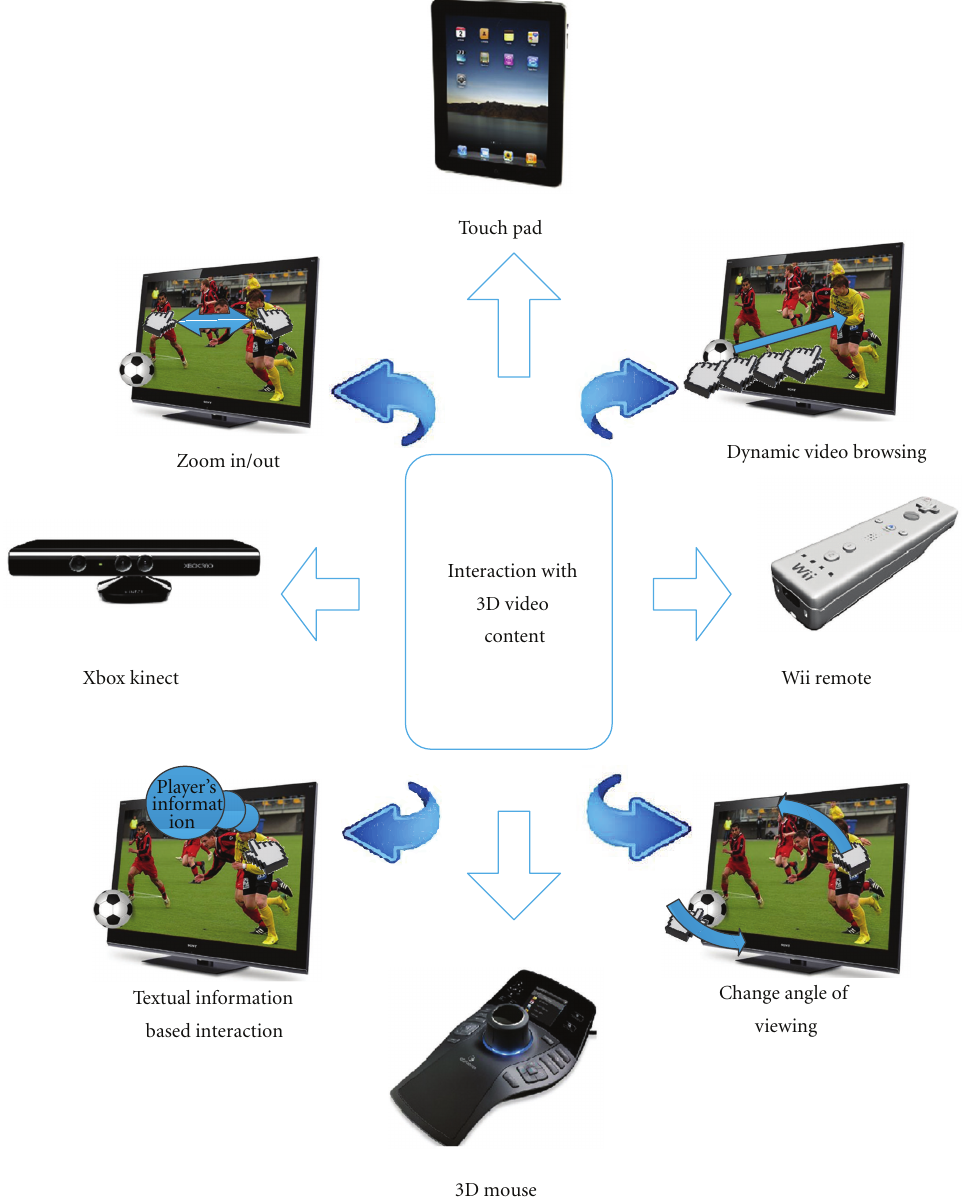
Figure 1: Derived user requirements for 3D video